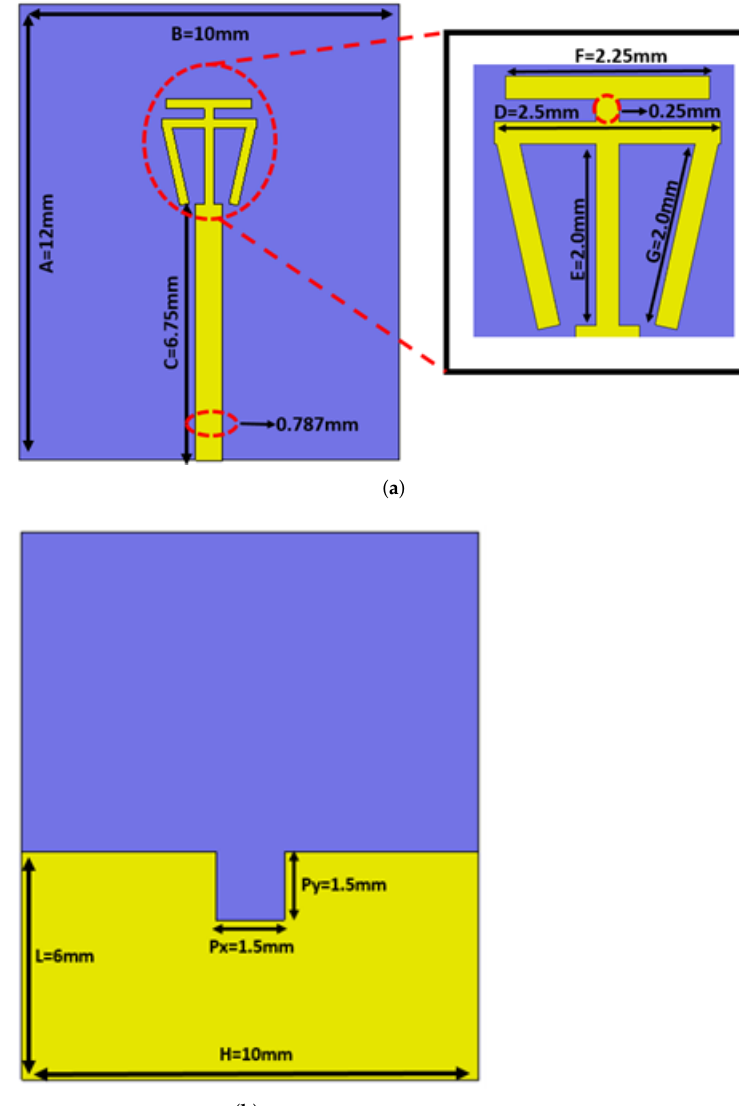
Figure 1. Proposed single antenna element ( a ) front-view and ( b )